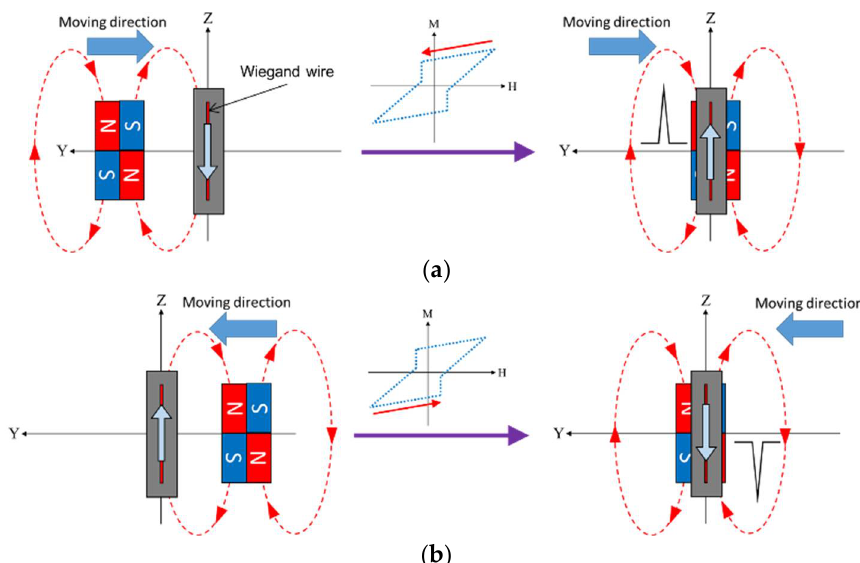
Figure 9. Schematic illustration of the process of pulse signal generation as the magnet pair is moved along the Y-axis from ( a ) left to the right and ( b ) right to the left.